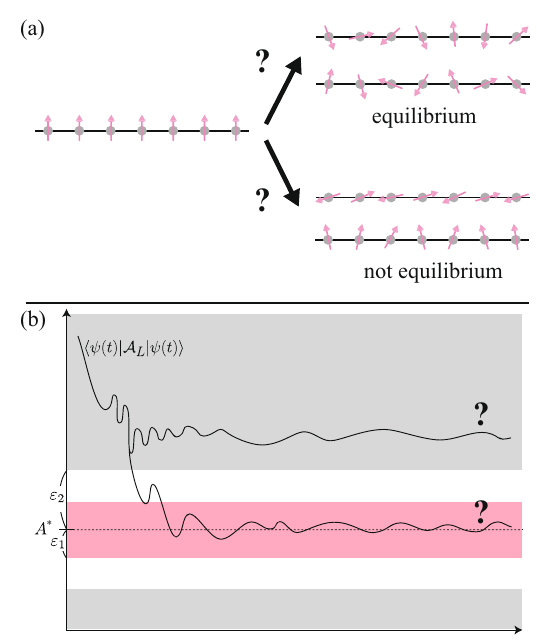
Fig. 1 The problem of thermalization concerns the long-time average of the observable. a We consider whether a nonequilibrium initial state relaxes to the equilibrium or not. b More precisely, we decide whether the (cid:8) (cid:3) long-time average of ψ ð t Þj A L j ψ ð t Þ converges to the value A * with precision ε 1 , or deviates from A * at least ε 2 > ε 1 , in the thermodynamic limit (If the long-time average settles between ε 1 and ε 2 , we do not have to answer). This problem is shown to be an undecidable